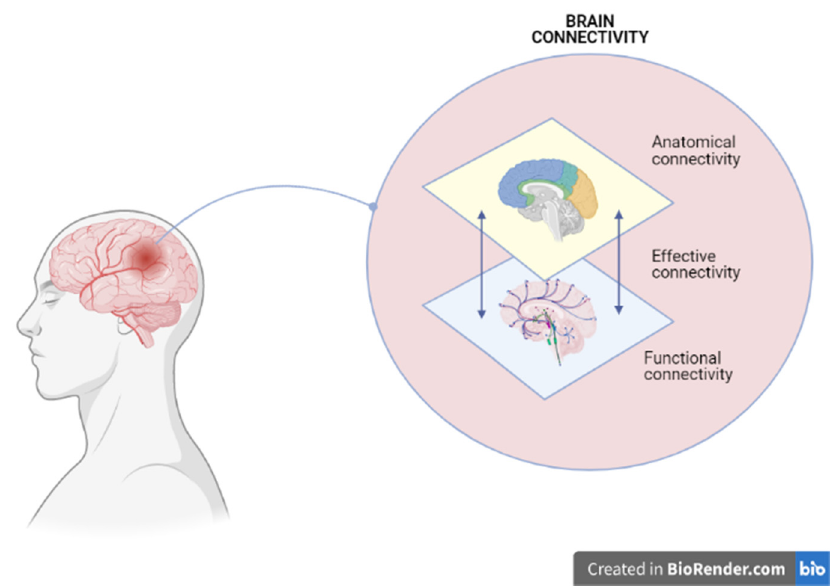
Figure 2. A severe brain injury may affect from one to all the patterns that constitute brain connectivity. Image created with BioRender.com (accessed on 1 March 2021).